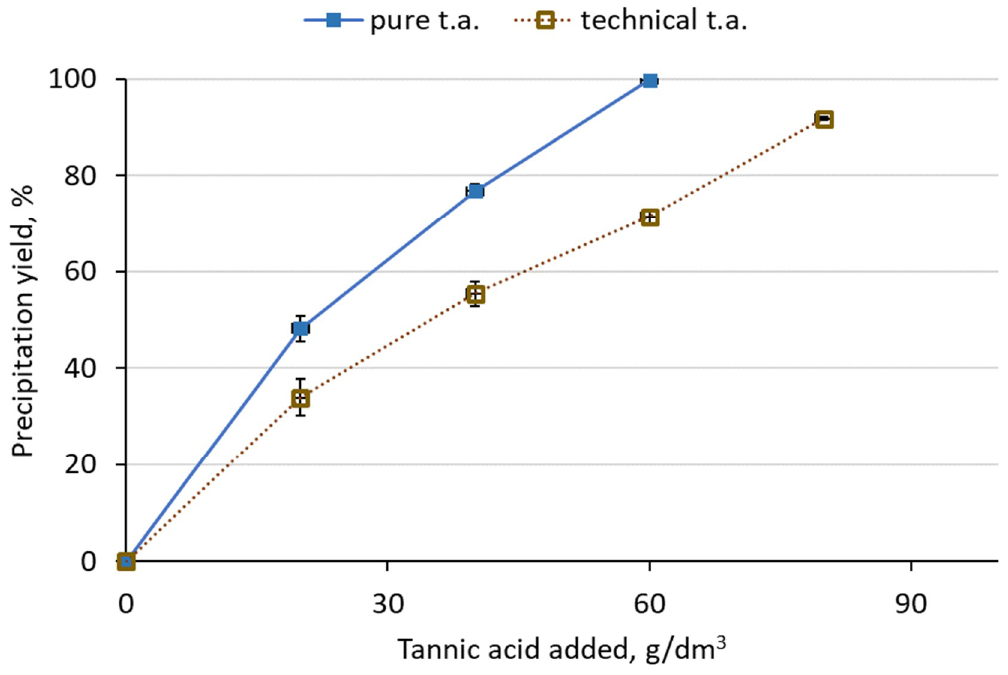
Figure 3. Influence of tannic acid purity on Ge precipitation yield in the solution (90 °C, tannic acid added in portions, 1 h between portions).